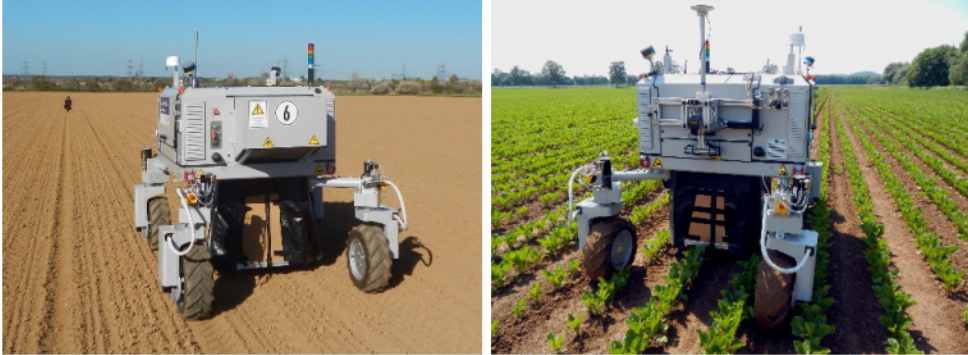
Figure 2. Field robot BoniRob